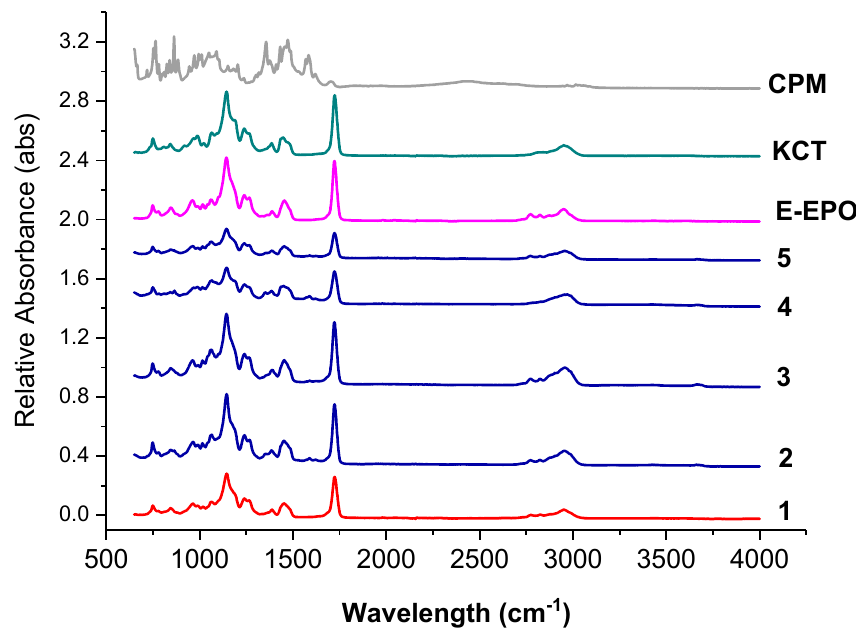
Figure 7. FTIR spectra of pure CPM, raw E-EPO, KCT, and the five co-axial systems electrospun. The formulations labelled 1 to 5 compositions are as detailed in Table 1.